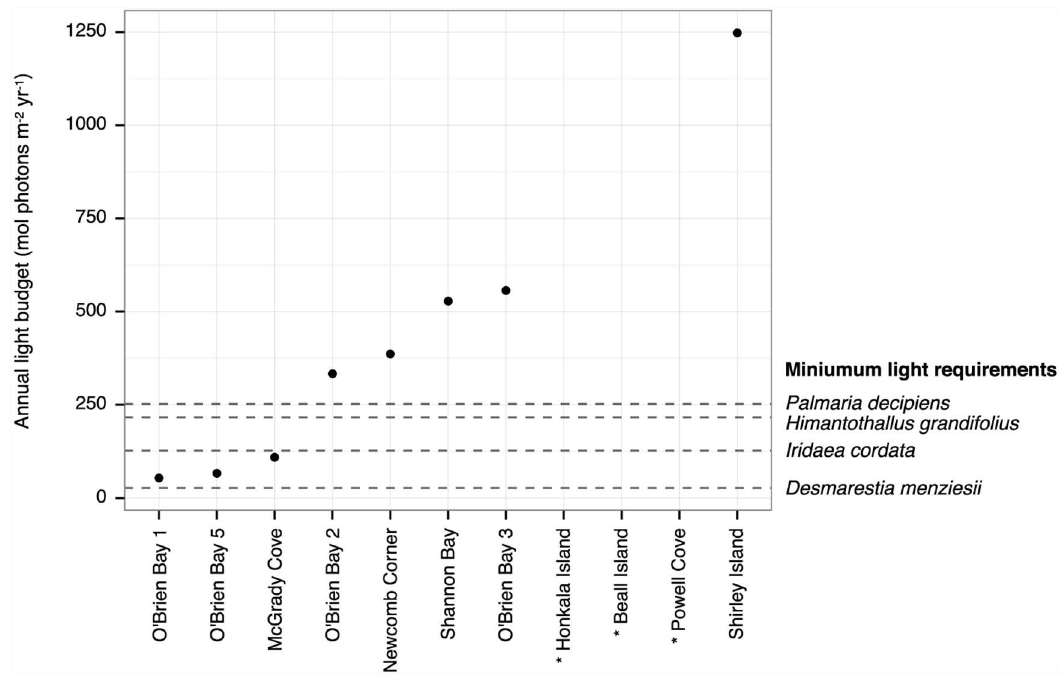
Fig 2. Annual Light Budgets (ALB) at the seabed. Points represent ALB recordedby light meters during the first year of deployment, and dashed lines are estimated minimum annuallight requirements of four species of local algae (from Clark et al. 2013). Algae species are expectedto be viable at sites where the ALB is abovetheir minimumrequirement.Light measurements are not available for three sites marked with * , but from long-term visual observation we know their annual timing of sea-icedepartureand therefore approximate light